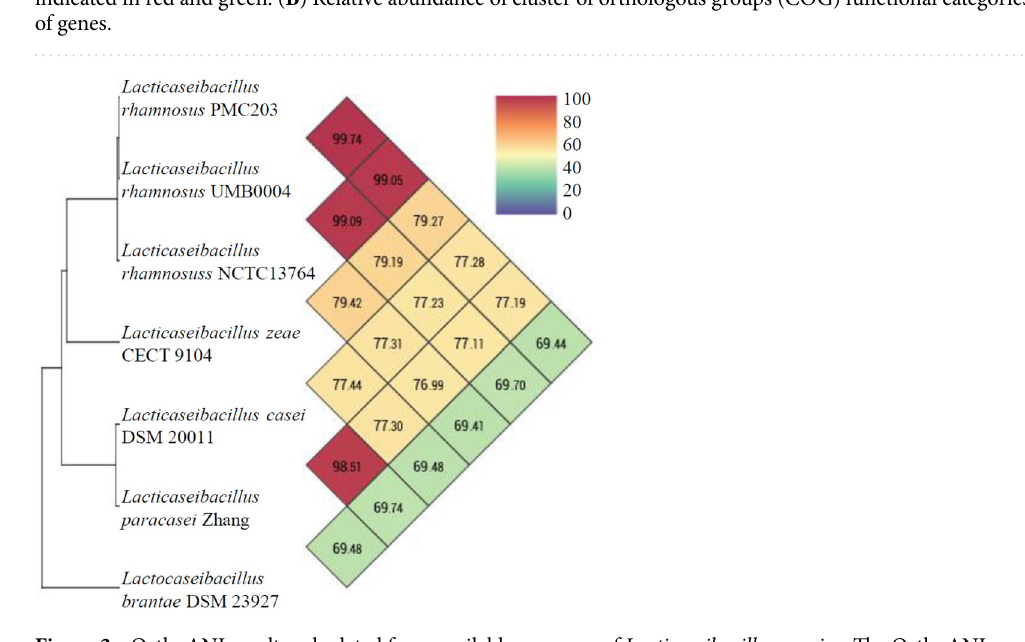
Figure 3. OrthoANI results calculated from available genomes of Lacticaseibacillus species. The OrthoANI value of L. rhamnosus PMC203 and L. rhamnosus UMB0004 was 99.74, higher than 96.0%, the standard for determining the same